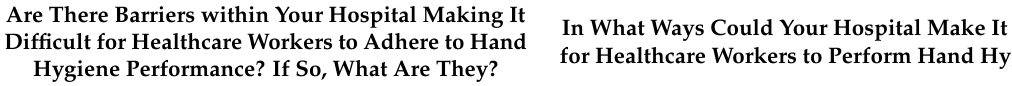
Table 2. Factors affecting hand hygiene compliance.